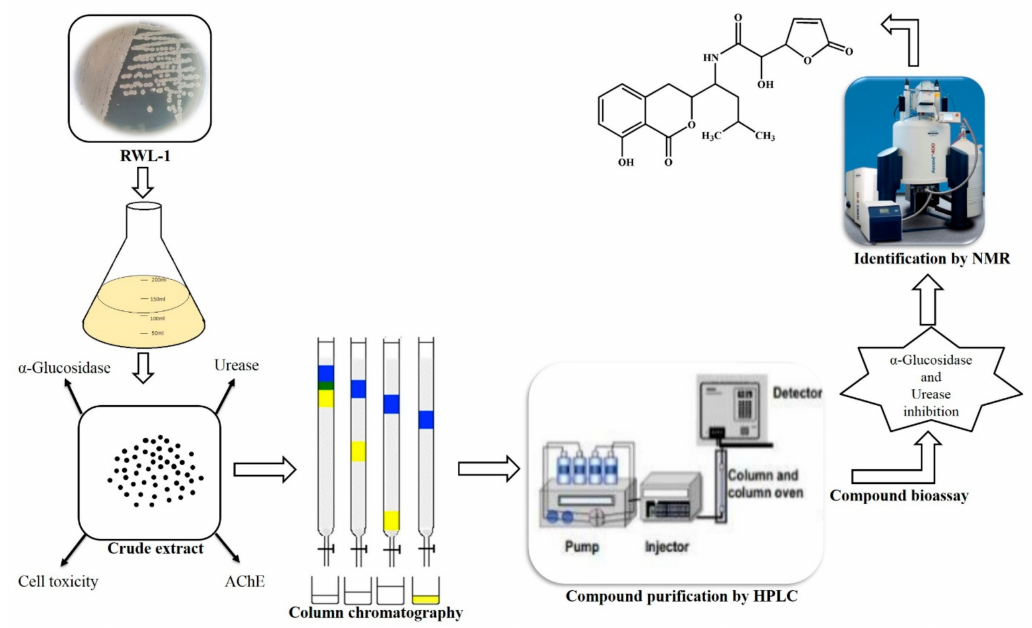
Figure 4. Schematic representation of biological potential of endophytic B. amyloliquefaciens RWL-1